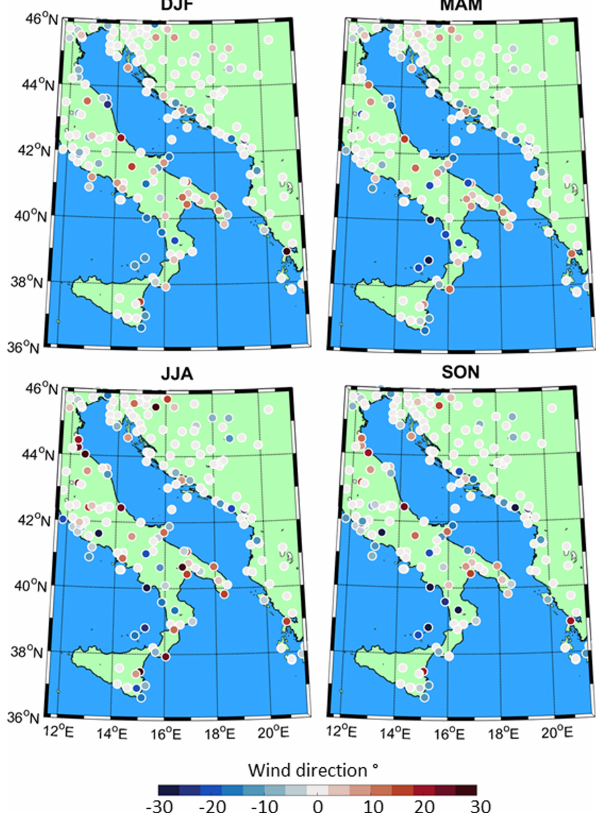
Figure 14. The same as in Fig. 10 but for the hourly wind speed bias.